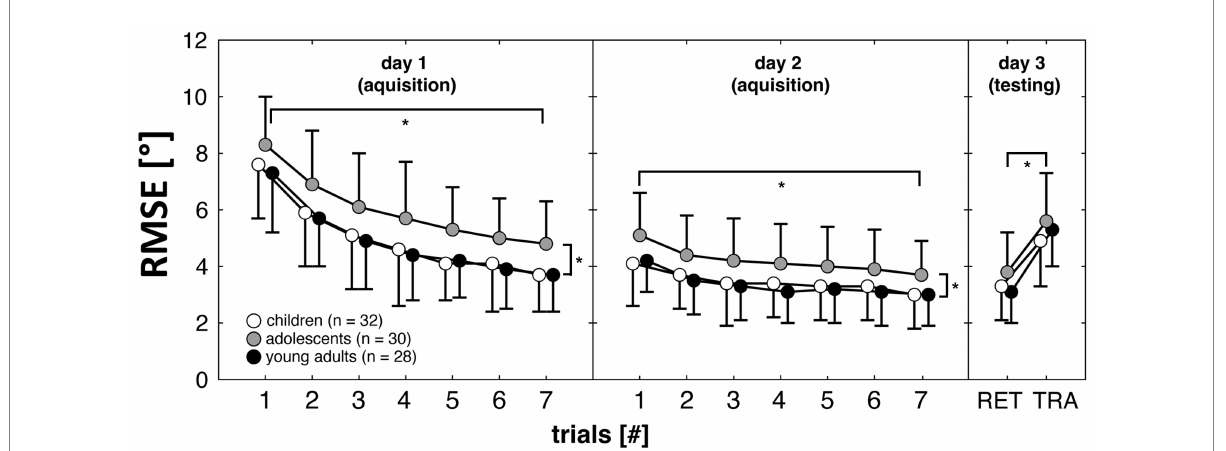
FIGURE 2 Root mean square error (RMSE) in degree for the children (unfilled circles), adolescents (grey filled circles), and young adults (black filled circles) during acquisition (day 1 and day 2) and during testing (day 3). Data represent means and standard deviations. *Represents a statistically significant difference ( p < 0.05). RET, retention test (i.e., balance task only); TRA, transfer test (i.e., balance task plus concurrent motor interference